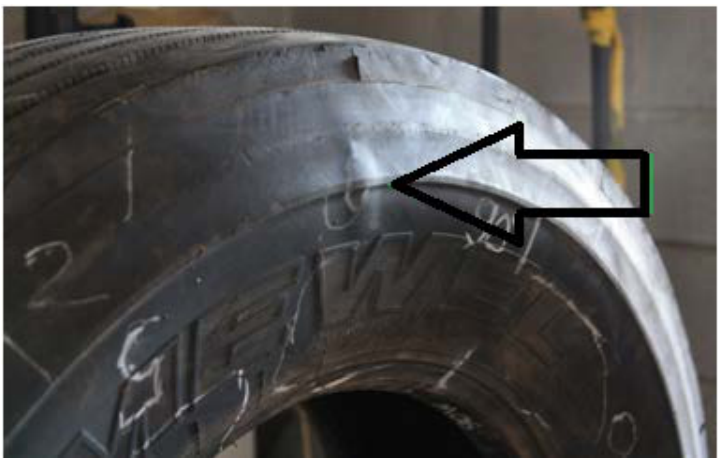
Figure 7. Local deformation of the sidewall on the inner side (indicated by an arrow).